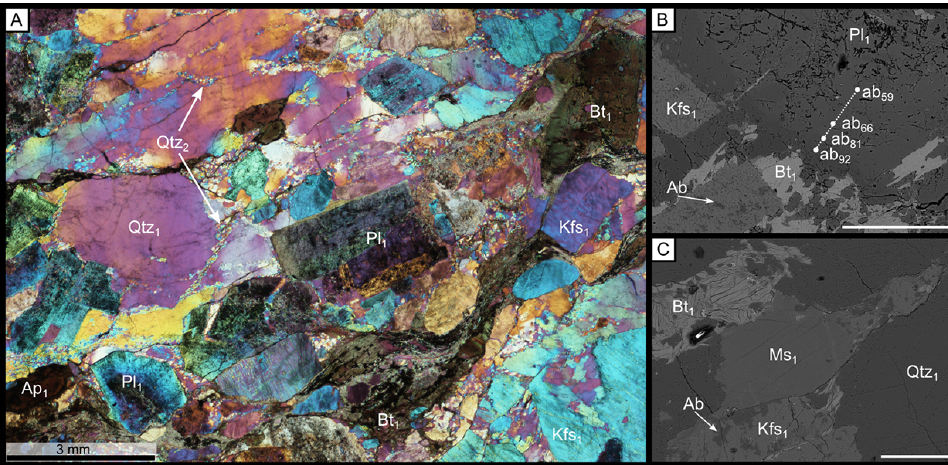
Figure 4. Typical microstructures and mineral assemblages in the wall rock; scale bar for (b) – (c) is 200µm. (a) Optical micrograph (crossed polarizers with gypsum plate inserted) showing undulose extinction in quartz (Qtz 1 ) , transecting Qtz 1 grains, euhedral feldspar grains (Pl 1 , Kfs 1 ) and Bt 1 . Arrows points to developing Qtz 2 domains, which often associate with Qtz 1 grains; (b) BSE image showing compositional zonation in plagioclase Pl 1 and albite exsolution lamellae in Kfs 1 ; (c) BSE image showing the microstructure of the igneous phyllosilicates (Bt 1 and Ms 1 ) characterized by large cleaved and kinked